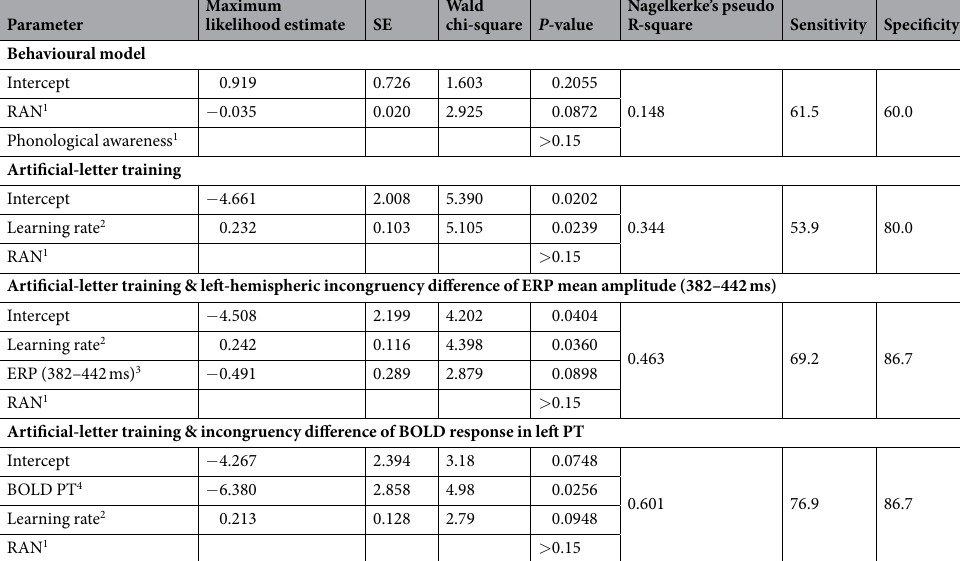
Table 2. Multiple logistic regression models ( n = 28). 1 Percentile scores; 2 training duration in minutes; 3 mean